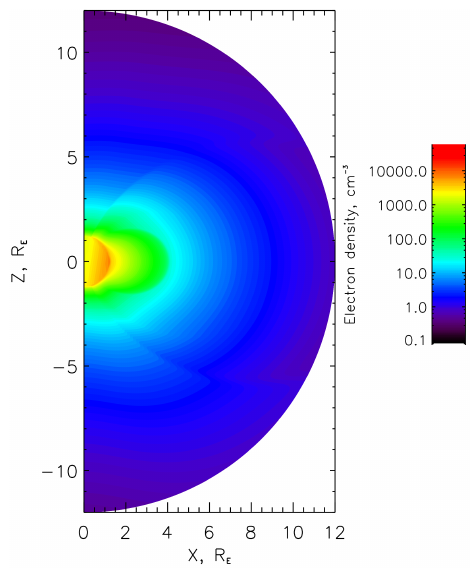
Figure 1. The employed model of electron density, given by the GCPM 2.2 model for the date 8 September 2002 at 05:00UT, with MLT = 09:00 and K p = 4. The plasmapause is clearly defined here at L =